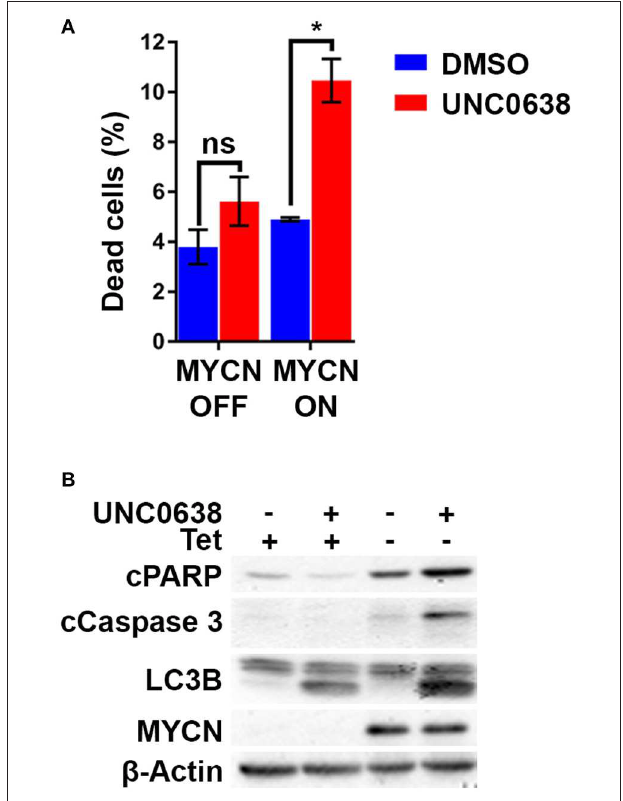
FIGURE 7 | UNC0638 leads to apoptosis of MYCN overexpressing S21N cells. (A) Floating and adherent cells from S21N cells with and without induced MYCN were harvested and counted by trypan blue inclusion assay following 5 µ M UNC0638 treatment at 72h. The charts show the percentage dead and live cells between treated and control. Error bars are SEM. (* p < 0.05, ns not significant, n = 3). (B) Western blot of induced and uninduced S21N cells treated with 5 µ M UNC0638 for